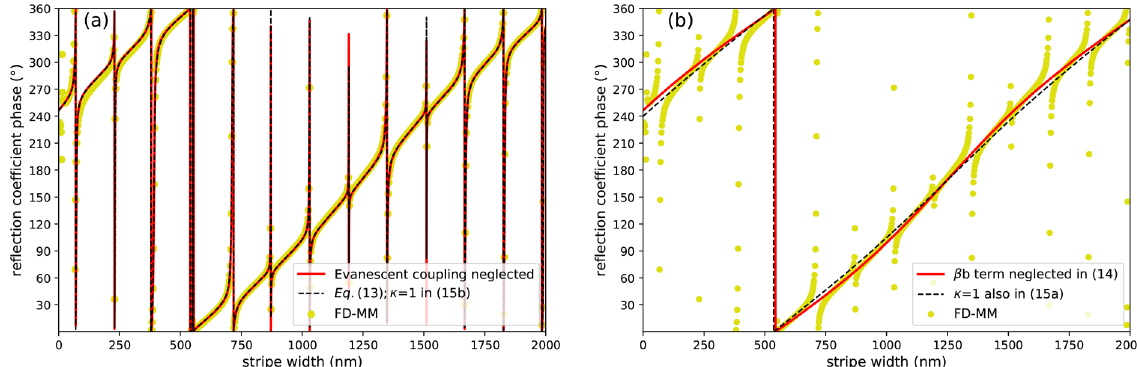
Figure 7. Comparison of the reflection coefficient phase calculated numerically using the finite-element modal method FD-MM (points) with the semi-analytical model from Eq. (14) at varying degrees of approximation (lines). Details in the plot legends and in the text.